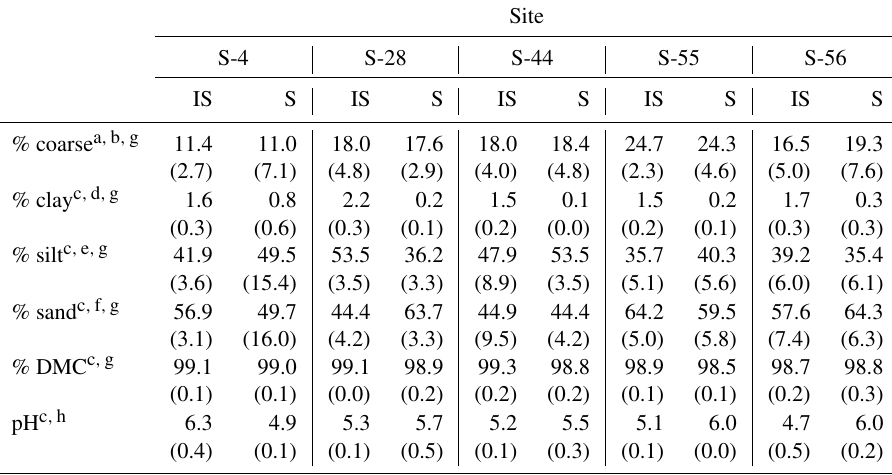
Table 1. Median textural characteristics, dry matter content (DMC), and pH (1 : 5 soil:0.01 M CaCl 2 ) for the surface soil layer (top 10cm) beneath inter-shrub (IS) and shrub (S) canopy cover types along a gradient of shrub encroachment in a semi-arid grassland of the Santa Rita Experimental Range, AZ, US. Values in parentheses represent 1 median absolute deviation about the median.